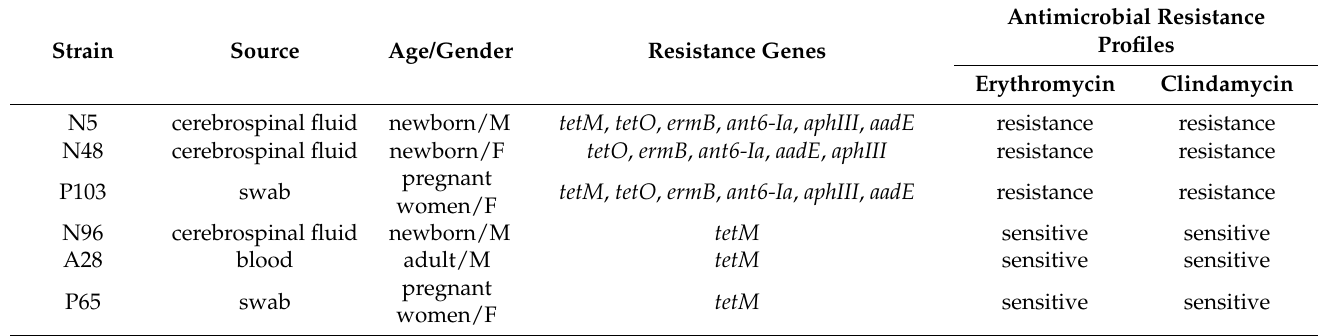
Table 3. Information for the six serotype III/ST-17 group B streptococcus (GBS)